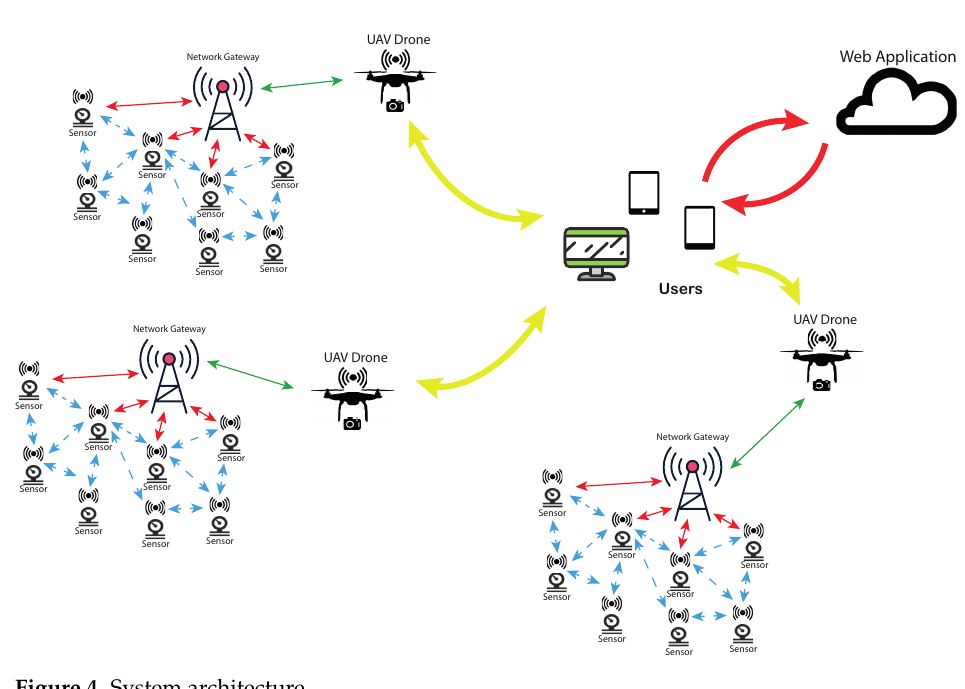
Figure 4. System